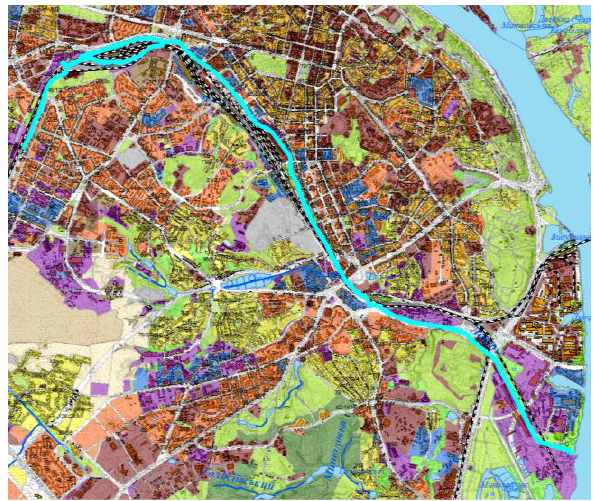
Figure 3. The Lybid river is compared with the functional use types of the city territory (according to the General Plan till 2020). The notation is identical to Fig. 2.